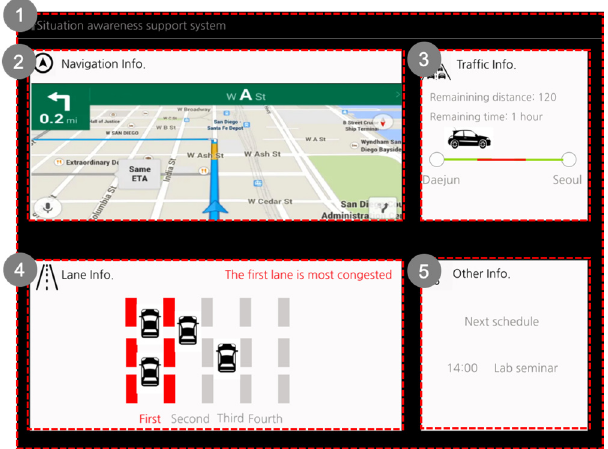
Figure 10. Descriptions of the main screen of the SA aiding system (Source: Own creation): ( 1 ) The main screen consists of four sections to provide global SA and high priority information for each section; ( 2 ) Navigation route guidance (No real data due to GPS disconnection); ( 3 ) Traffic information (it indicates traffic information on the route); ( 4 ) Lane information (The color highlights which lane is free or heavy); and ( 5 ) Other information (the personal schedule which can influence the driving strategy).